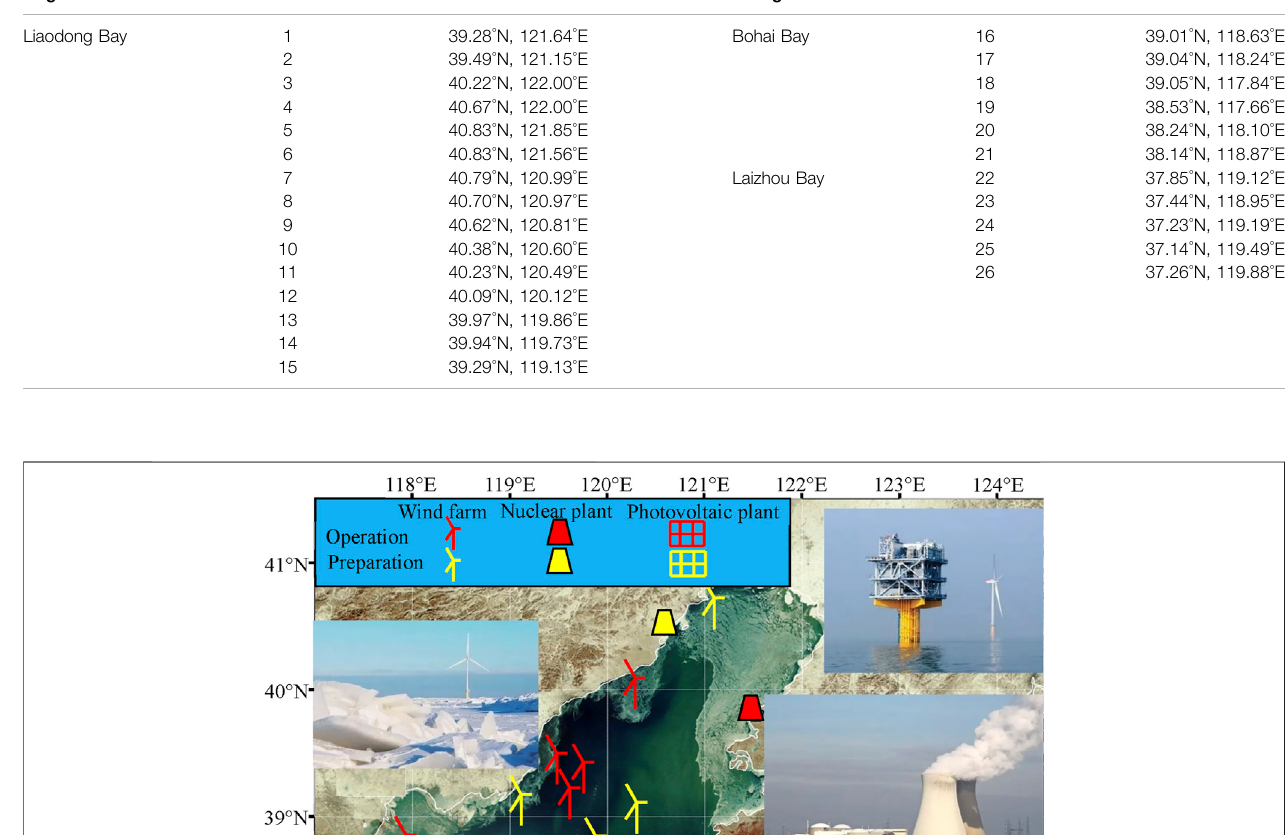
Frontiers in Energy Research |